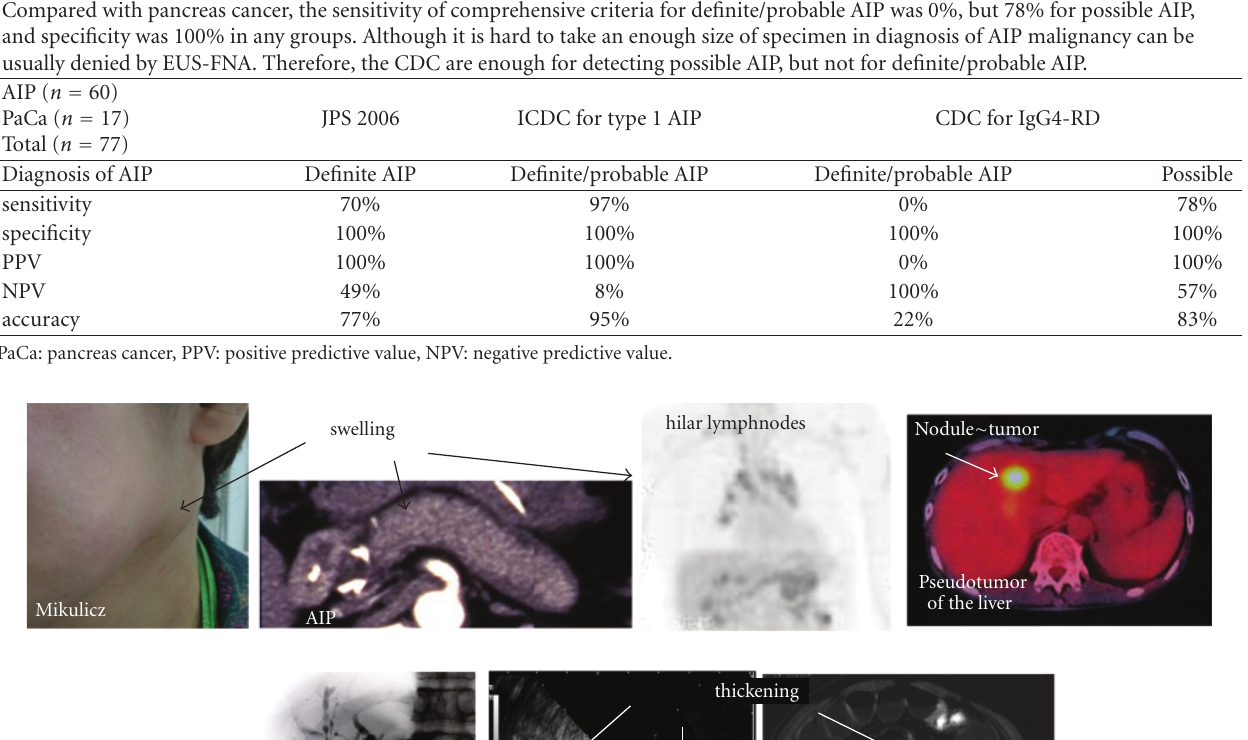
Table 7: Validation of a combination of CDC and organ-specific criteria for type 1 AIP.